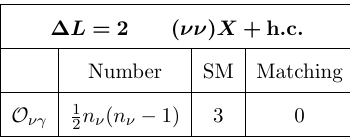
Table 10 . Dimension-five ∆ L = 2 Majorana neutrino dipole operators in LEFT. There are also † Hermitian conjugate ∆ L = 2 operators , as indicated in the table heading. The second column νγ − O is the number of operators for an arbitrary number of neutrino flavors n ν , and the third column is number in the SM LEFT with n ν = 3. The last column is the tree-level matching coefficient in SMEFT, which vanishes.